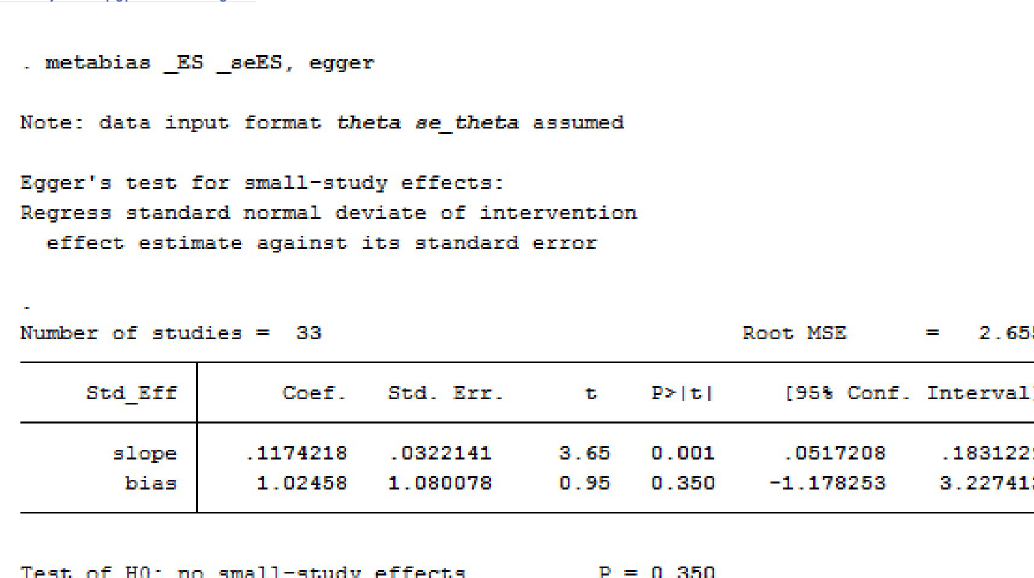
Fig 8. Distribution of studies included in the prevalence of obesity among adults in Nigeria in the meta funnel plot.